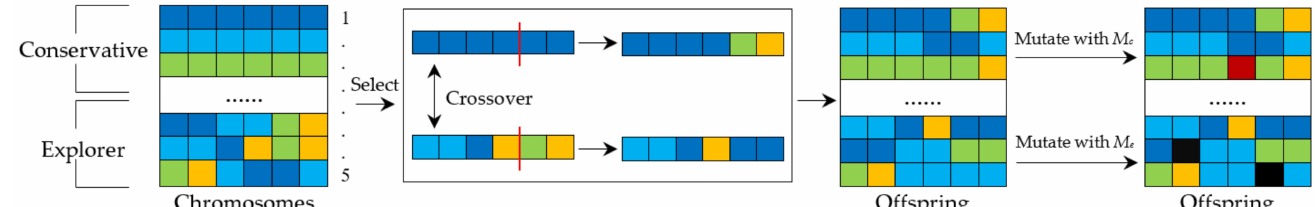
Figure 3. Mechanism for the crossover and mutation operators of the MSGA.